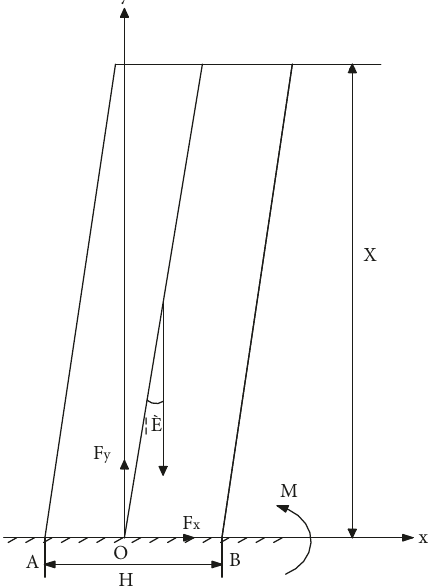
Figure 5: Structural mechanical model of rock column cantilever